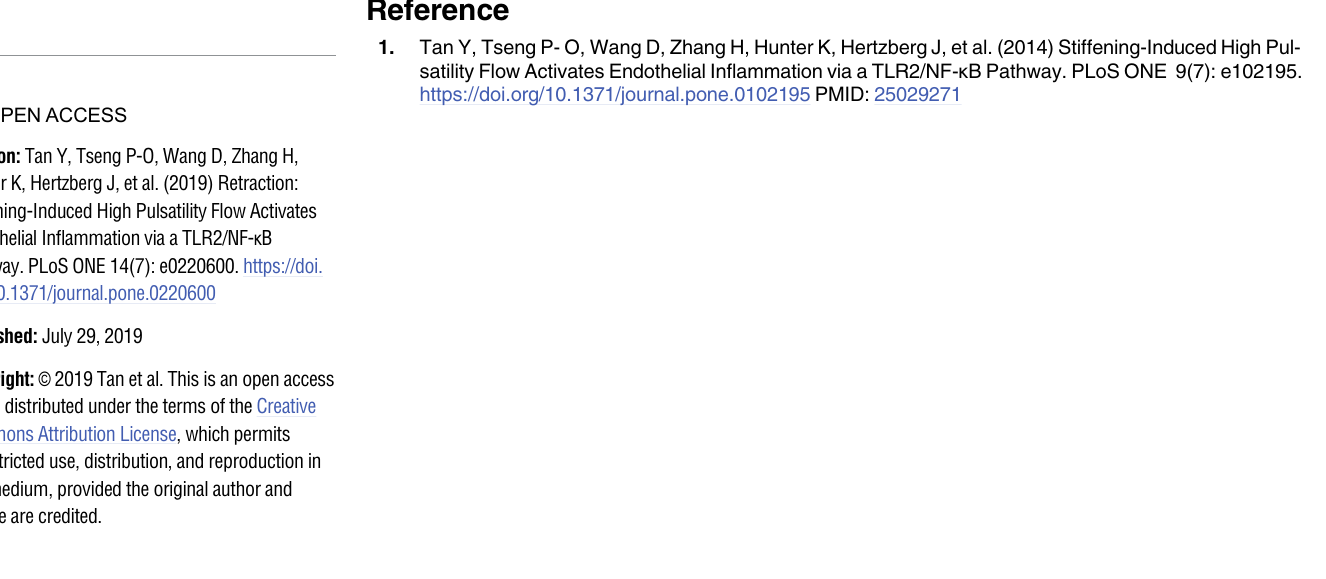
• Fig 2B GAPDH lane 1, Fig 3B GAPDH lane 5, and Fig 3D (left panel) GAPDH lane 4 • Fig 2B GAPDH lane 2, Fig 3B GAPDH lane 2, Fig 3D (left panel) GAPDH lane 2, and Fig 4C GAPDH lane 1 • Fig 3B GAPDH lane 3 and Fig 4C GAPDH lane 2 • Fig 3B GAPDH lane 4, Fig 3D (left panel) GAPDH lane 3, and Fig 4C GAPDH lane 4 • Fig 3B, GAPDH lane 6, Fig 3D (left panel) GAPDH lane 1, and Fig 4C GAPDH lane